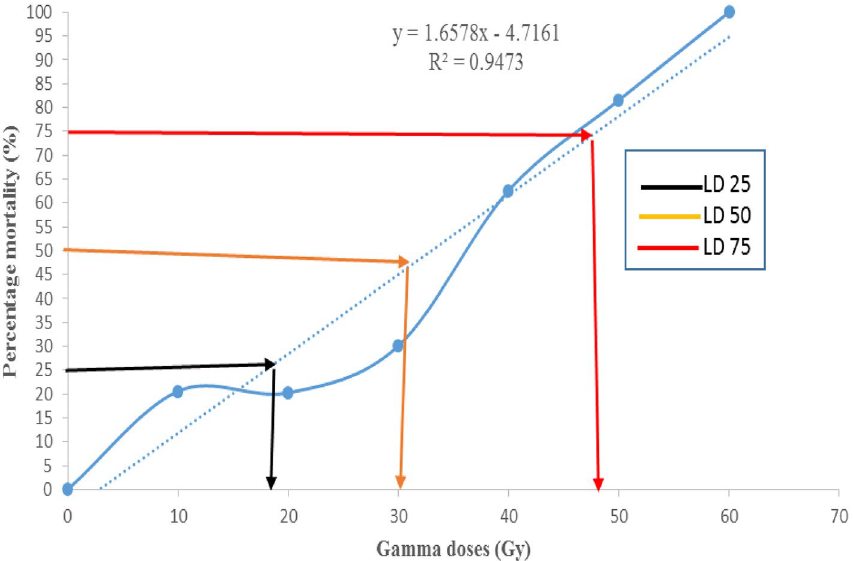
Figure 1. Analysis of Lethal dose (LD) on ‘Yaghouti’ grape ( Vitis vinifera L.) cultivar irradiated with different doses of